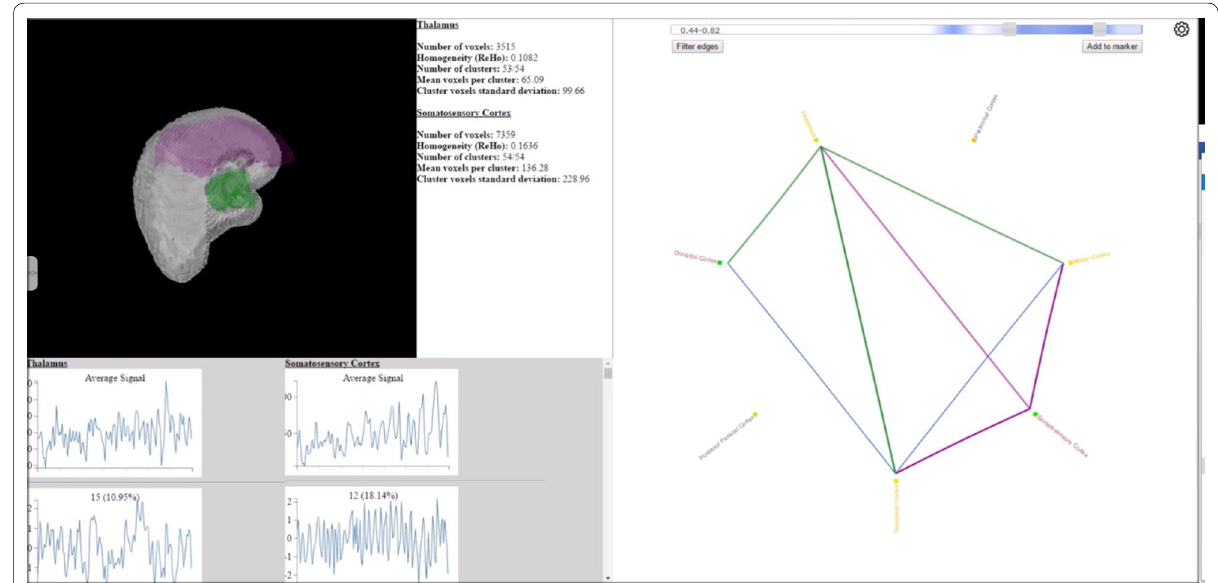
Fig. 12 Example of viewing fMRI from multiple angles in CereVA [91]. The three linked views are statically placed, so users always know where to look, minimising visual searching. Each of the elements also presents a different view of the underlying fMRI data, which is designed to assist with uncovering the data uncertainties alongside minimising human issues, such as cognitive